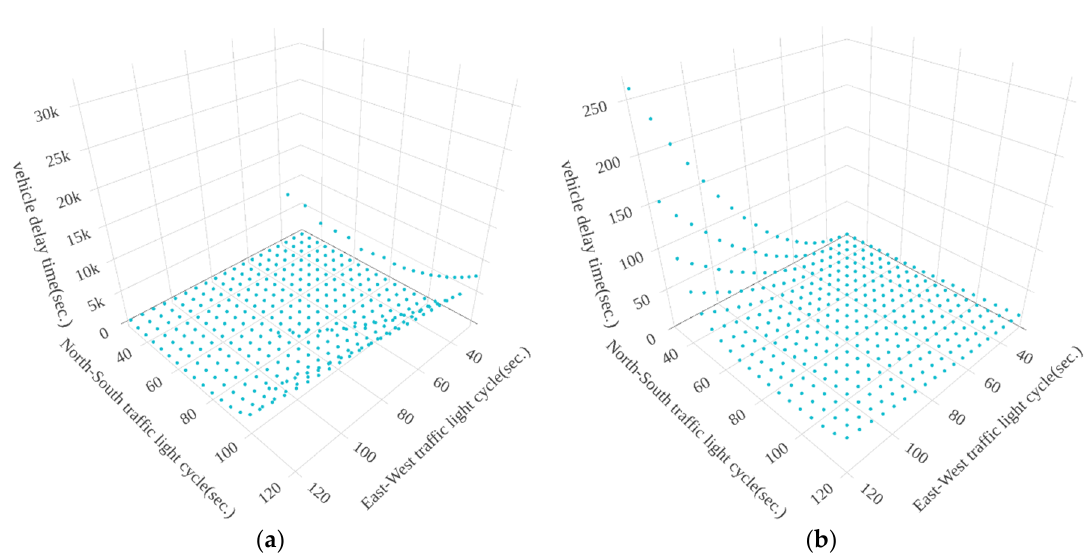
Figure 12. The results of vehicle delay by using exhaustive search method on Yanping N. Rd. and Minsheng W. Rd. ( a ) from 8:00 a.m. to 9:00 a.m. ( b ) from 5:00 p.m. to 6:00 p.m.